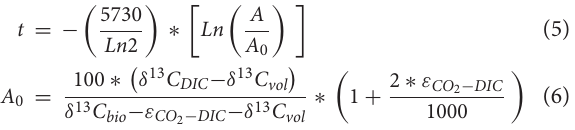
a measurable concentration (0.6 TU), indicating recent